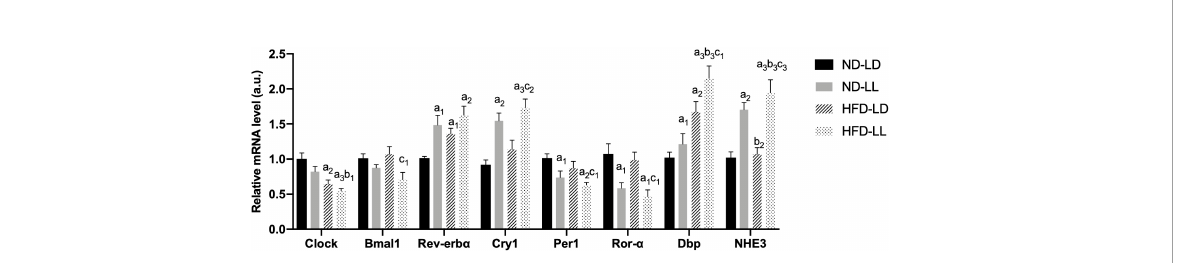
FIGURE 6 Changes in expression of clock genes in kidneys of rats. Quantitative PCR analysis of mRNA levels of renal circadian clock genes respectively. Values represent mean ± SEM (n=6-8). Differences were determined using a one-way ANOVA followed by a Bonferroni post hoc analysis. a1 p <0.05, a2 p <0.01, a3 p <0.001 vs. ND-LD group; b1 p <0.05, b2 p <0.01, b3 p <0.001 vs. ND-LL group; c1 p <0.05, c2 p <0.01, c3 p <0.001 vs. HFD-LL group. Bmal1, brain and muscle ARNT-like protein 1; Per1, period circadian regulator 1; Cry1, cryptochrome circadian regulator 1; Ror- a , RAR- related orphan receptor- a ; DBP, D site albumin promoter binding protein; NHE3, Na + /H + exchanger